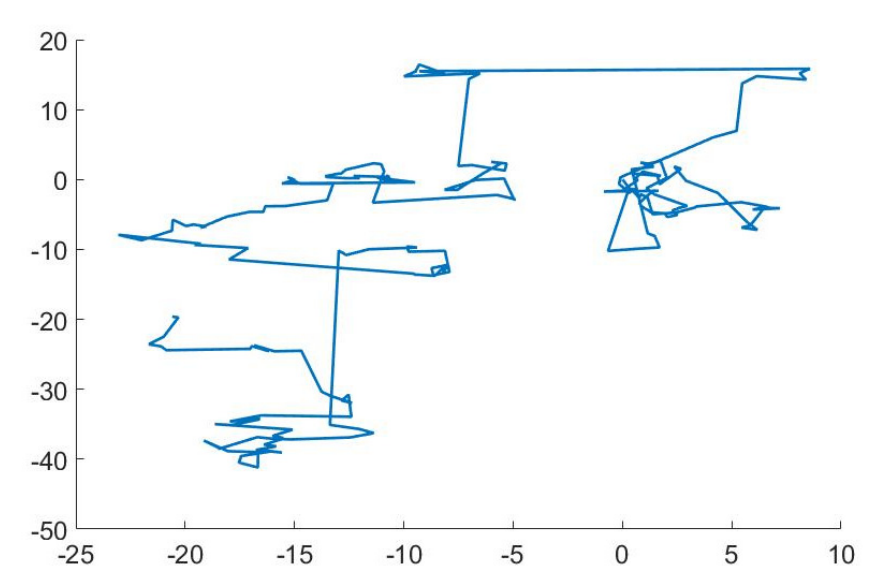
Figure 8. Movement of Levy flights.